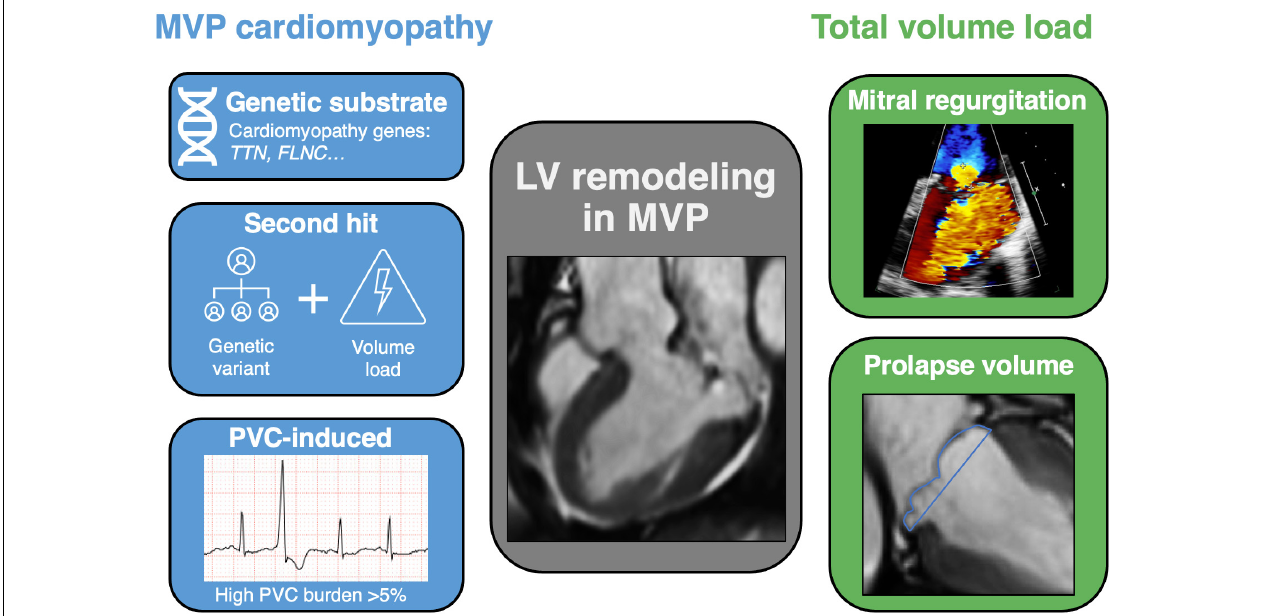
FIGURE 3 | Central image: mechanisms of left ventricular remodeling in mitral valve prolapse. Schematic view of LV remodeling mechanisms in MVP, addressing the hypothesis of a cardiomyopathy on the left and total volume load on the right. Different pathophysiological mechanisms exist regarding the development of a cardiomyopathy in MVP, including a genetic substrate, second hit phenomenon and PVC-induced remodeling. On the other hand, the excessive volume load of chronic MR itself can induce LV dilatation, especially when a significant prolapse volume is added to the total volume load. LV, left ventricular; MVP, mitral valve prolapse; MR, mitral regurgitation; CMR, cardiac magnetic resonance imaging; TTN , titin; FLNC , filamin C; PVC, premature ventricular